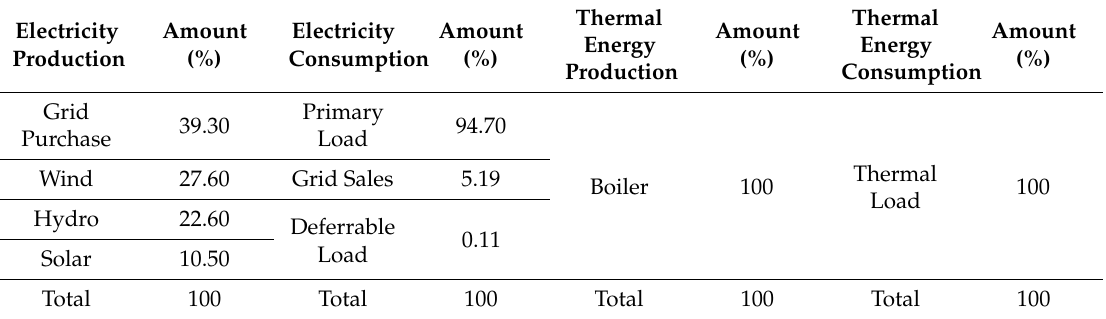
Table 10. Energy production and consumption scenario of grid-connected mode for the first year of project life